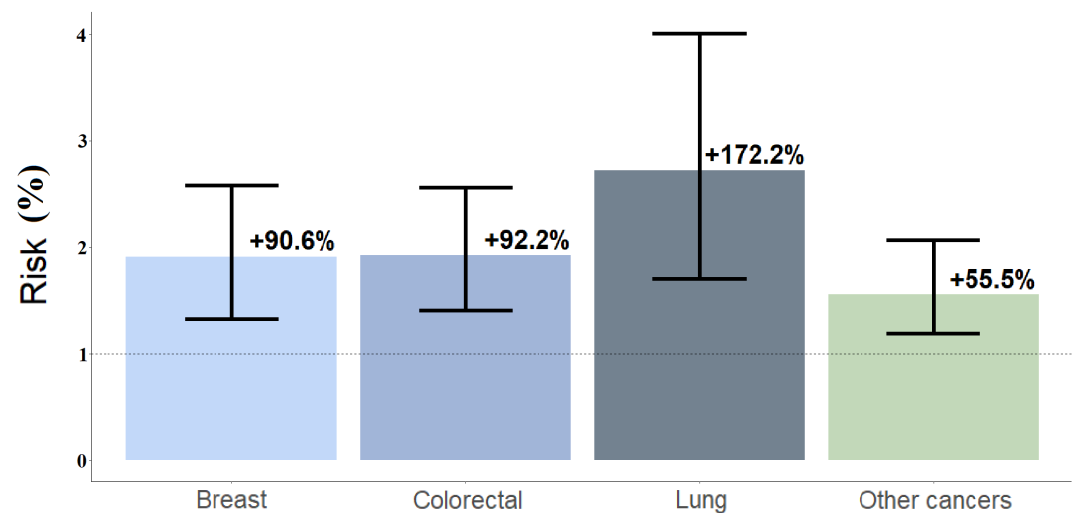
Figure 4. Simulation 1 refers to simulated odds ratios (SORs); percentages are labeled. This was performed for y oung patients (≤55 years old) with bone metastases and ROO use and young patients with bone metastases vs. those with no bone metastases. SORs for lung cancer were 2.72 (95%CI = 1.70 – 4.01); colorectal cancer 1.92 (95%CI = 1.40 – 2.56); other cancers 1.55 (95%CI = 1.19 – 2.07); breast cancer 1.91 (95%CI = 1.32, 2.58).